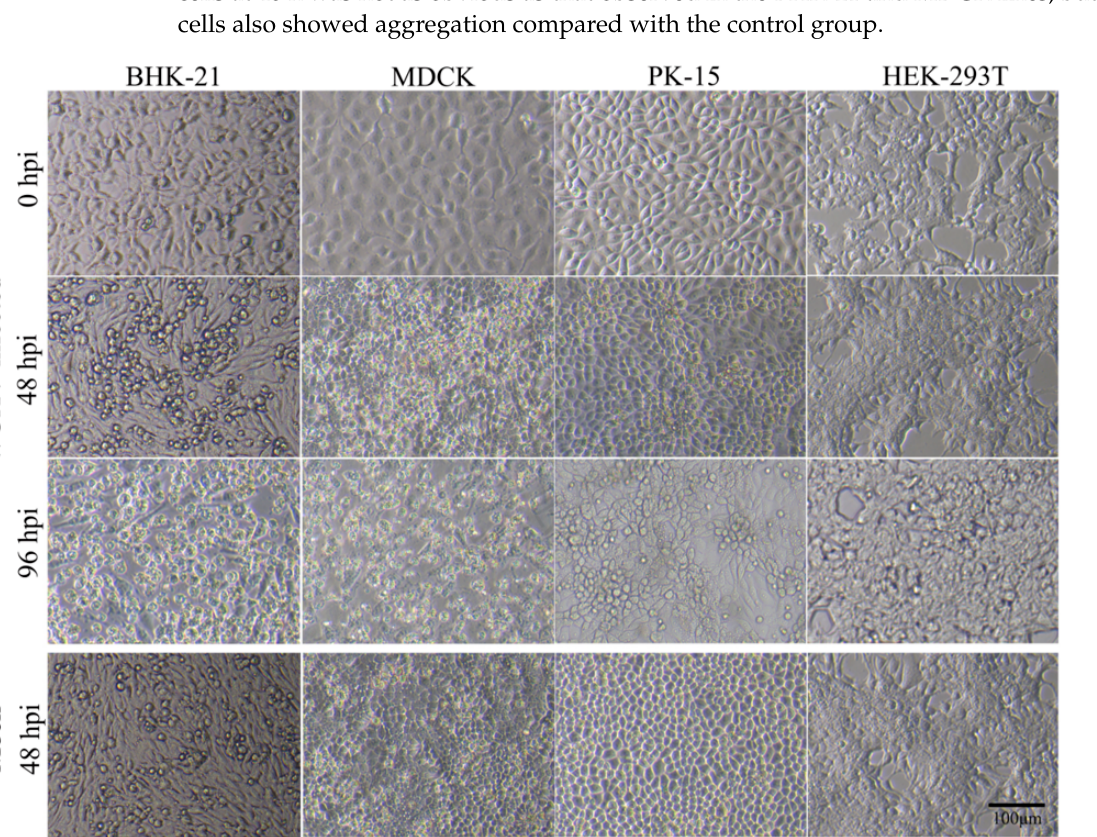
Figure 2. Cell numbers and viability following infection with WUXV SXWX1813 ‐ 2. ( A ) BHK ‐ 21, ( B ) MDCK, ( C ) PK ‐ 15 and ( D ) HEK ‐ 293T cells were infected with WUXV SXWX1813 ‐ 2 at a multiplicity (MOI) of 0.05 and collected at 0, 24, 48, 72, and 96 hpi; mock ‐ infected samples were collected at 0, 48, and 96 hpi. Left panels show the absolute numbers of total cells and viable cells per well at each